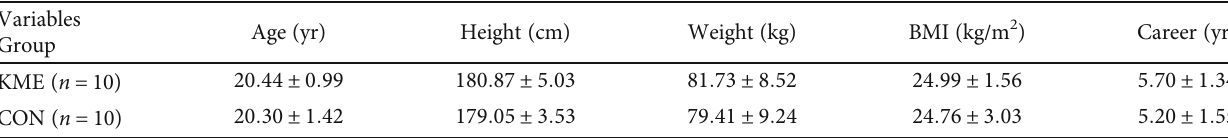
Figure 1: Overview of intervention study design. The pre- and postsupplementation was performed in the experiment in the same condition and methods. Rowing performance measures (2,000m rowing ergometer race simulation) were completed before and after each supplementation period (the mistletoe supplement group and the control group). Venous blood samples at the baseline were assessed before the subjects underwent rowing ergometer test. After the exercise, venous blood measures were assessed immediately and after 30 minutes. The KME group took 110mL of mistletoe extract immediately after the exercise. Table 1: Physical characteristics of subjects in both